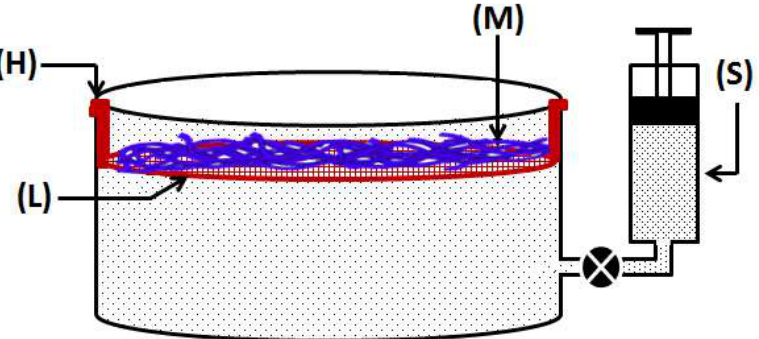
Figure 1. Schematic diagram of customized apparatus used for fabrication of in situ self-assembled bacterial cellulose-electrospun nanofiber hybrid mats.